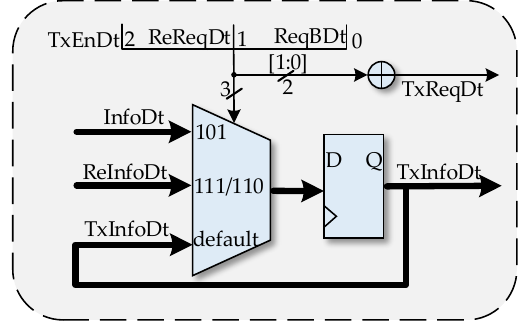
Figure 5. Circuit design of the RCU for data frames.